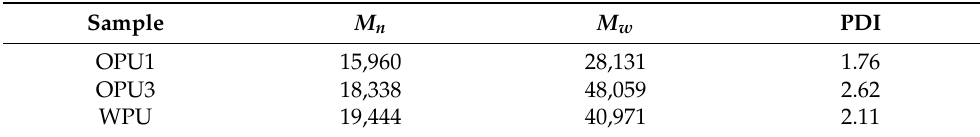
Table 1. Molecular weight of WPU and